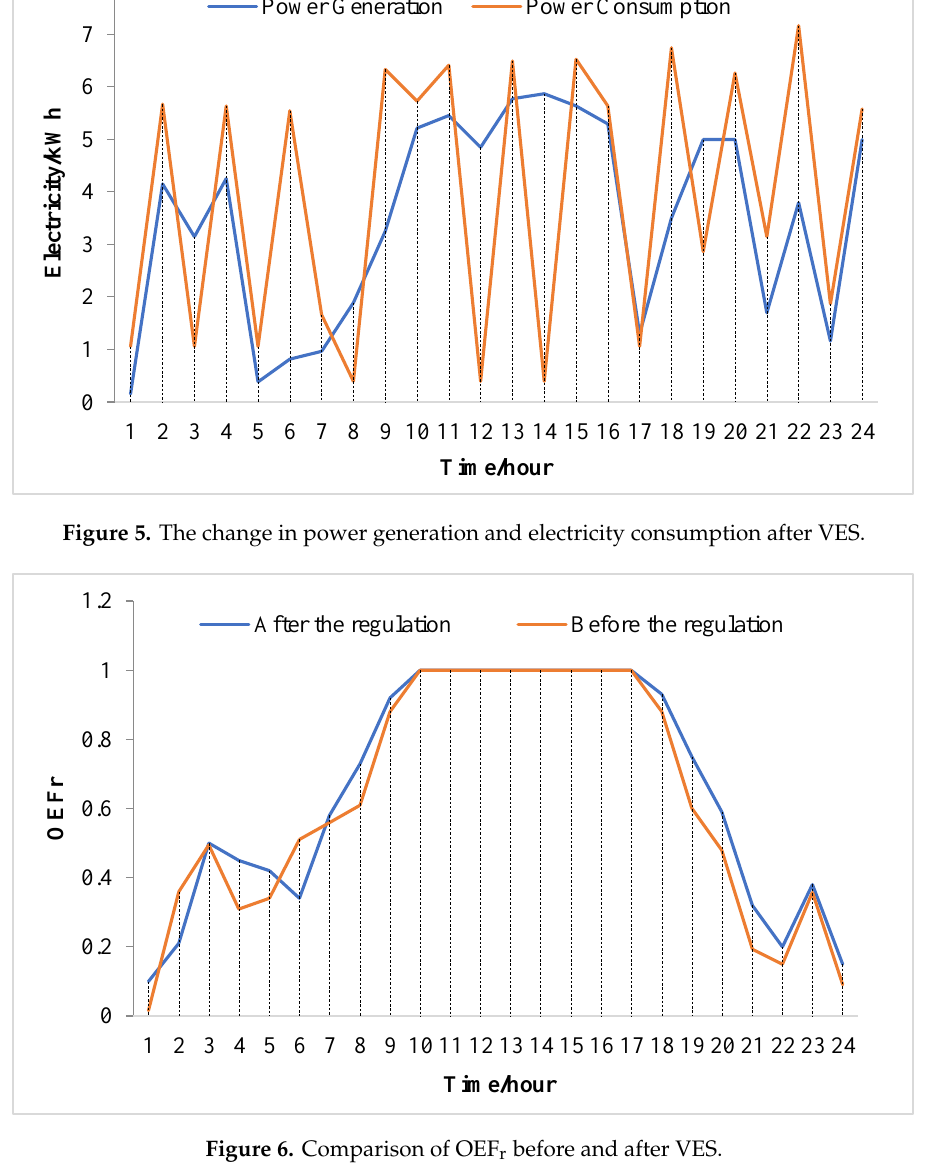
Figure 6. Comparison of OEF r before and after VES.